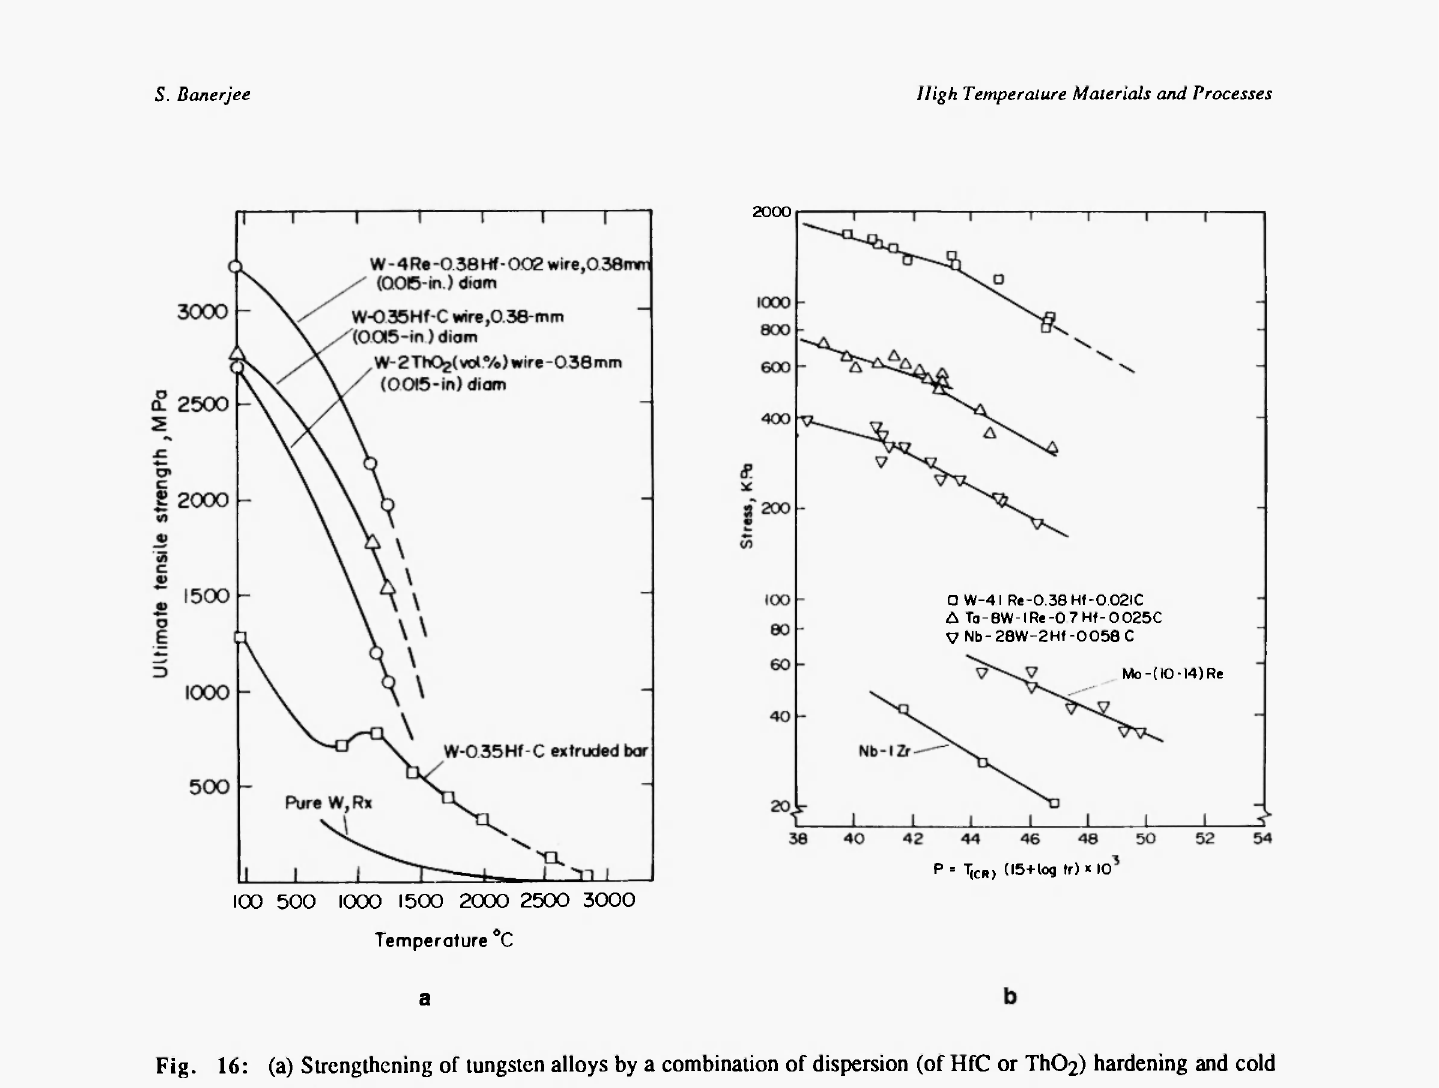
16: (a) Strengthening of tungsten alloys by a combination of dispersion (of HfC or ThC >2) hardening and cold